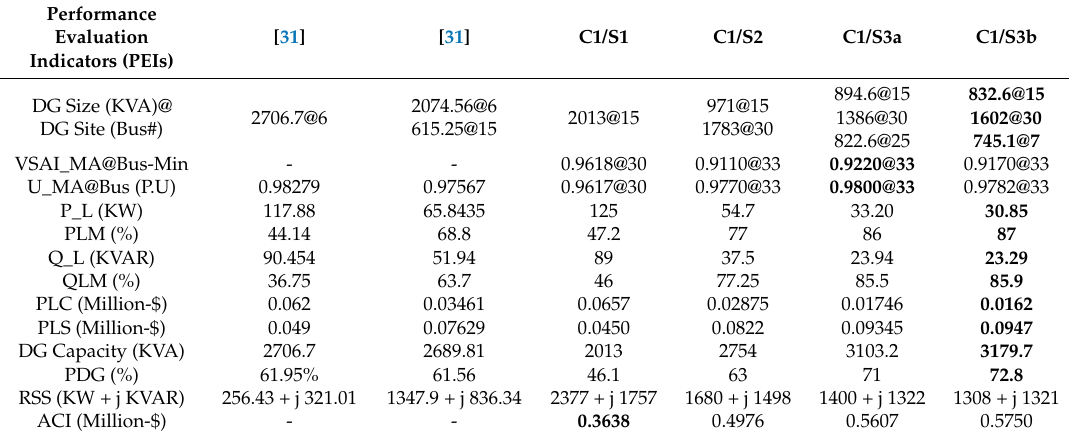
Table 7. Comparisons of results with various scenarios of Case 1 for 33-Bus test system (DG @ pf = 0.90 ± 2.5%).